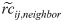
Correlation between predicted and experimental thermostabilities (T
m values) of BsLipA variants; for the predictions, the ENTFNC approach was used.
A: Correlation between T
p derived from the global index H
type2 and T
m values for thermodynamically thermostabilized mutants from Rao et al. Data points colored red were considered outliers (see main text for explanation) and excluded when calculating R
2 values and the correlation lines. B: Correlation between rc˜ij,neighbor and T
m values for thermodynamically thermostabilized mutants from Rao et al. Data points shown as empty squares represent rc˜ij,neighbor values for five additional wild type crystal structures (see main text for details; two of the squares closely overlap; mean rc˜ij,neighbor over all six data points for wild type structures is shown as a small horizontal line: 315.9 ± 0.6 K). A and B: Error bars represent the standard error in the mean. T
p and rc˜ij,neighbor values for kinetically thermostabilized mutants from Reetz et al. are marked by arrows on the corresponding ordinates.